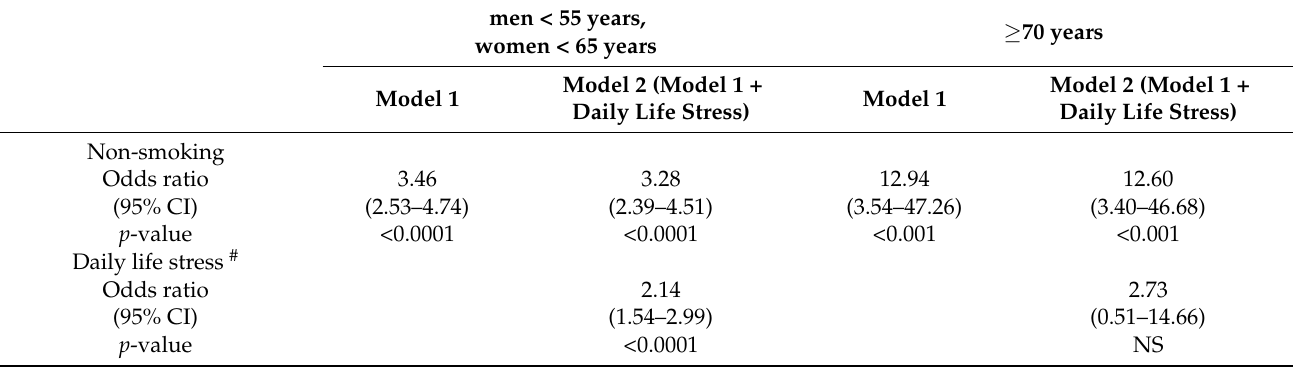
Table 3. Multivariate analyses of the contribution of environmental variables to the odds of CVE-free survival in FH